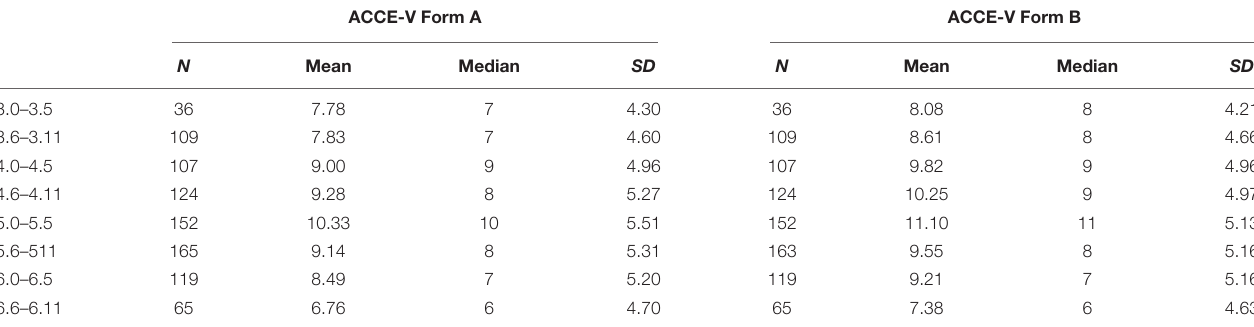
FIGURE 7 | Density plots showing the distribution of scores for the ACCE-V Form B. N = 1724 (877 for Form A, 875 for Form B). TABLE 7 | Number of children, mean score, median score, and standard deviation for 6-month age bands. ACCE-V Form A ACCE-V Form